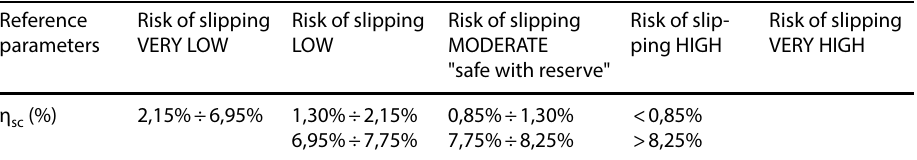
Table 2 Classification of slipping risk indices